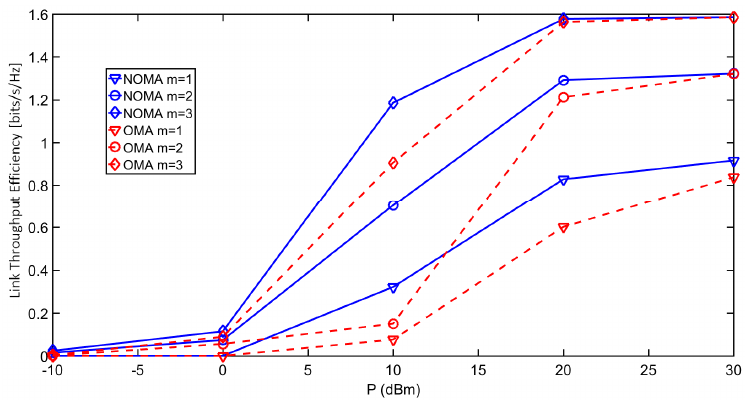
Figure 5. Link throughput efficiency comparison between NOMA and OMA. Sensors 2018 , 18 , x FOR PEER REVIEW